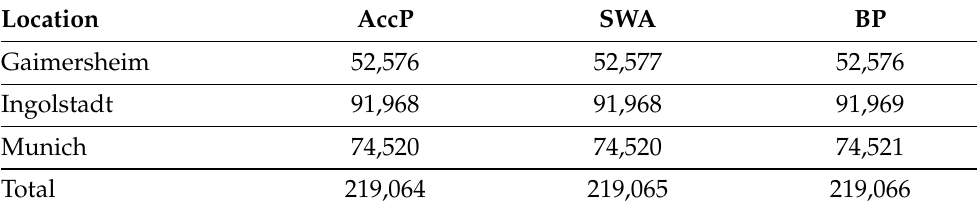
Table 3. Available A2D2 data-points from AccP, SWA and BP sensors for each recording location.